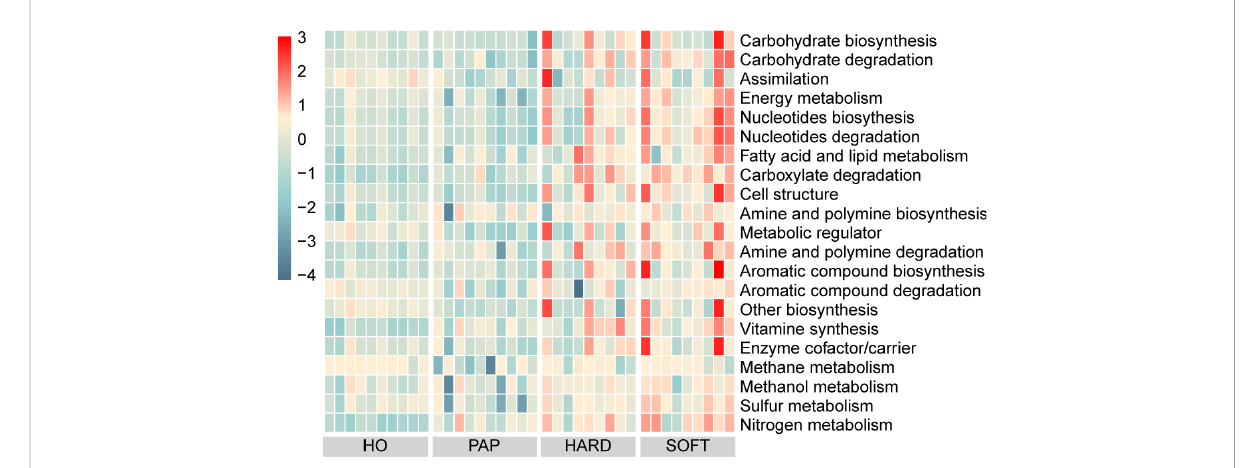
FIGURE 5 Heatmap showing differentially abundant metabolic pathways among HO, PAP, and persistent AP (HARD and SOFT). The abundance is predicted and normalized using PICRUSt2 with the default Metacyc database.